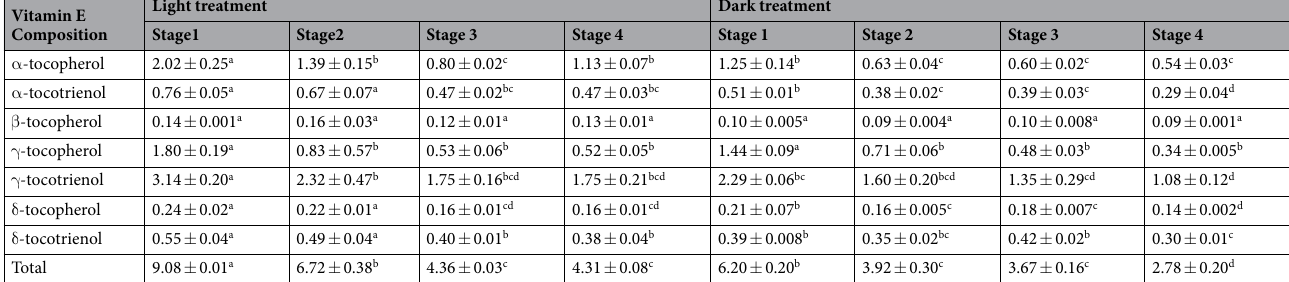
Table 1. Change of Vitamin E profiles in sweet corn during germination. Unit: mg/100 g DW; significance analysis was carried out within rows and data with different letters indicate significant difference at p < 0.05.